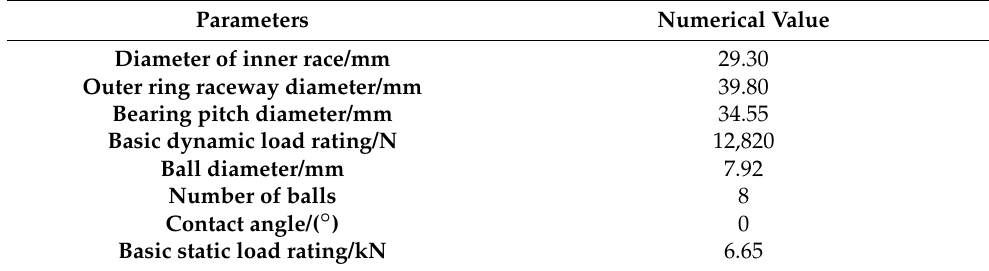
Table 1. LDK UER204 Bearing parameters.